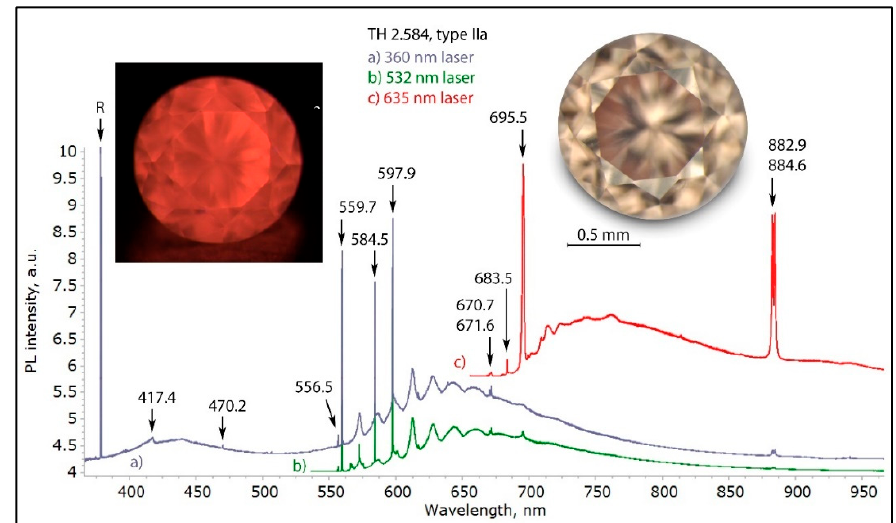
Figure 28. The photoluminescence spectra of a highly unusual pink brown type IIa diamond with orangey red luminescence not originating from the NV 0 center, but from the 559.7, 584.5, and 597.9 nm defects, excited using three different lasers. These are nickel-containing natural type IIa diamonds, as is apparent by the presence of the 882.9/884.6 nm Ni i+ doublet; the 584.5 and 597.9 nm defect(s) can possibly be attributed to oxygen or nickel defects. The spectra were shifted vertically for clarity.